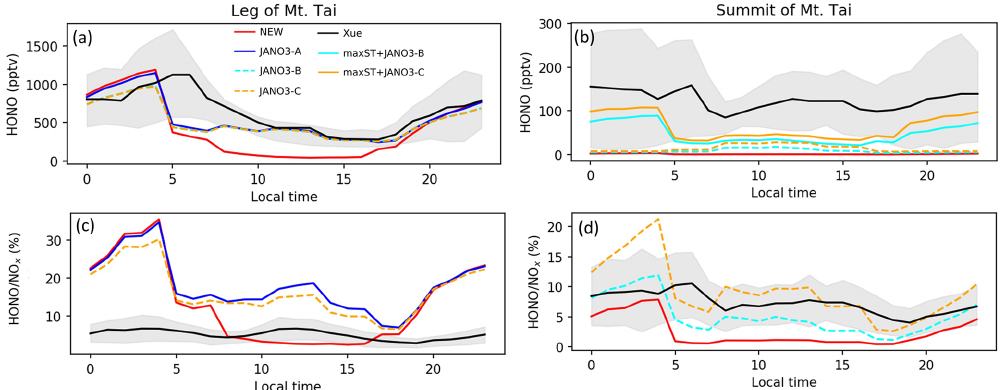
Figure 8. HONO and HONO : NO x ratio concentrations estimated in the model and reproduced from Xue et al. (2022a) for Mt Tai’s foot and summit stations during July. Shaded area shows minimum–maximum ranges, while colours show simulations as in legend.